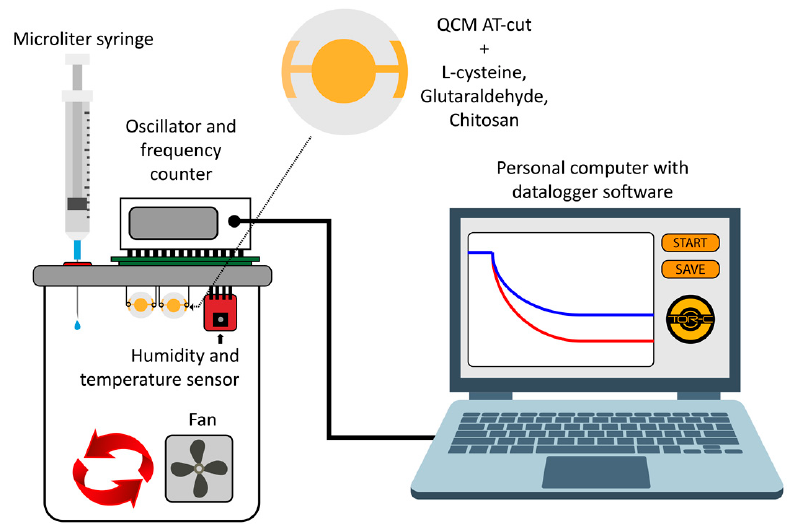
Figure 2. Experimental setup of the QCM system for gas or vapor sensing.